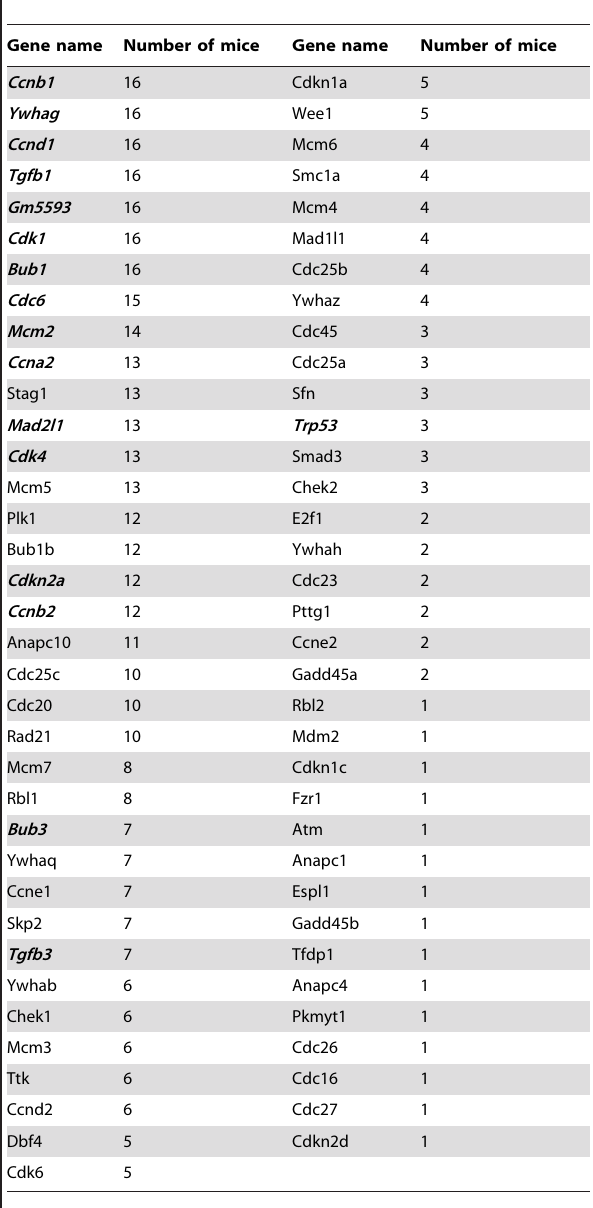
Analysis of gene lists (KEGG) from all 16 mice in which the DAVID annotation ‘‘cell cycle’’ was significant. Highlighted genes were also significant according to the average analysis of all 31 mice.